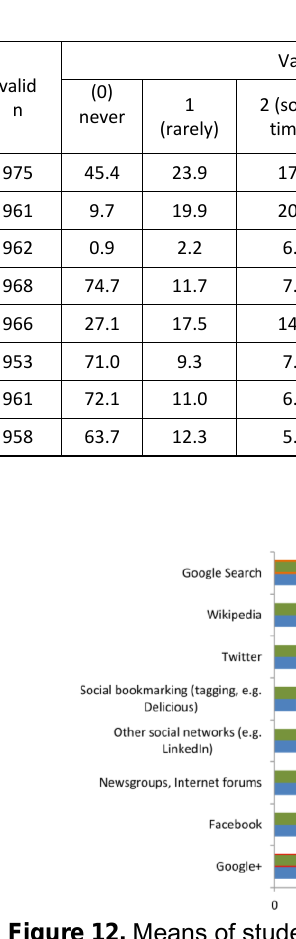
Table 10. Students’ answers to the question: How often do you use the following for le arning/studying?